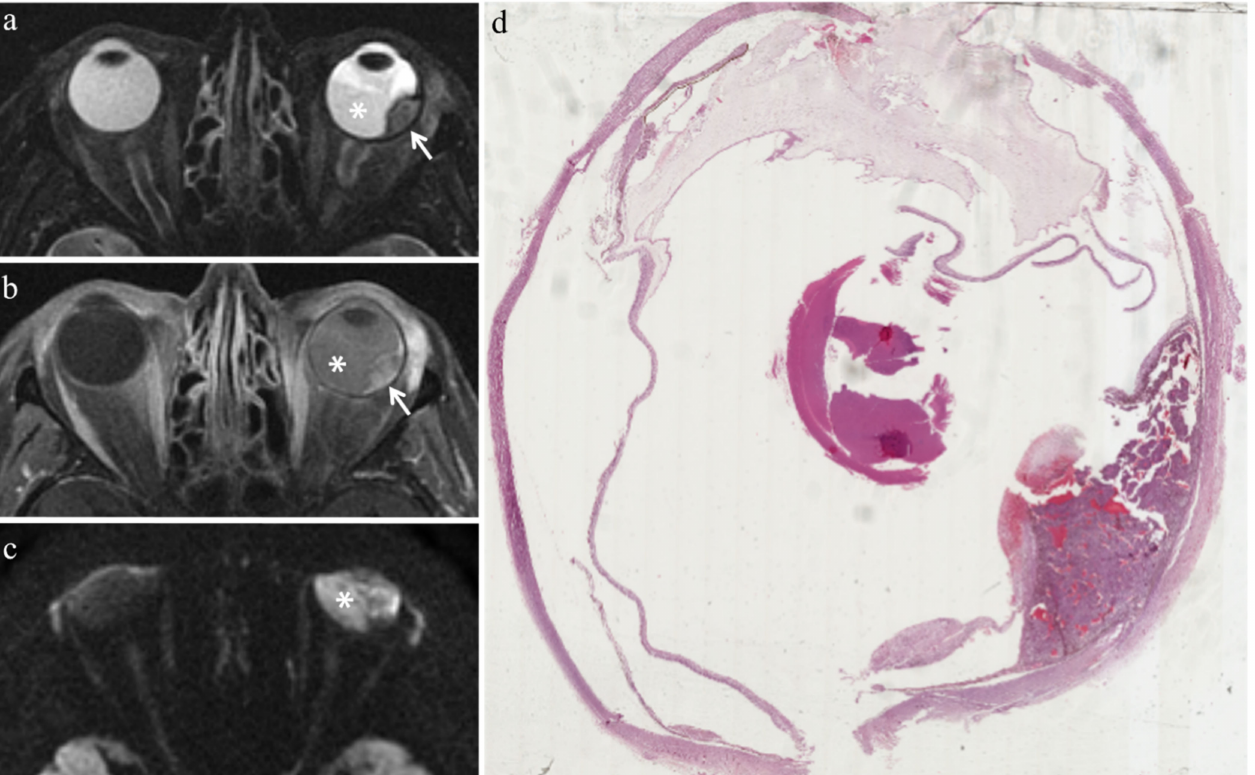
Figure 3. Vitreous hemorrhage. A 75-year-old female patient (patient n. 8 of our series) affected by choroidal melanoma of the left eye treated with proton beam radiotherapy. Secondary enucleation was carried out 14 months after radiotherapy because of local recurrence associated with treatment-related complications and eye pain. Axial ( a ) T2-weighted turbo spin-echo, ( b ) contrast-enhanced fat-suppressed T1-weighted, and ( c ) DW (b = 1000 s/mm 2 ) images. The left globe (white asterisks) exhibits increased signal intensity on the T1-weighted image and inhomogeneous signal intensity with fluid–fluid level on the T2-weighted image. On ( c ) the DW image the left vitreous body shows restricted diffusion with high signal intensity (white asterisk). These findings indicate a diffuse vitreous hemorrhage of the left eye. The physiological water-like signal intensity of the contralateral eye is preserved. A dome-shaped intraocular mass (white arrows in a and b ), representing the local recurrence of choroidal melanoma, is located along the temporal aspect of the left globe. ( d ) Histological examination on low magnification (H&E, original magnification 25 × ) confirms MRI findings demonstrating a poorly pigmented mass, protruding into the vitreous body, associated with vitreous